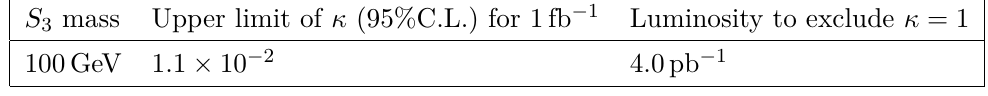
Table 3 . Expected sensitivity to search for S 3 with a mass of 100 GeV using 1 fb − 1 of Pb-Pb UPCs √ at s = 5 . 02